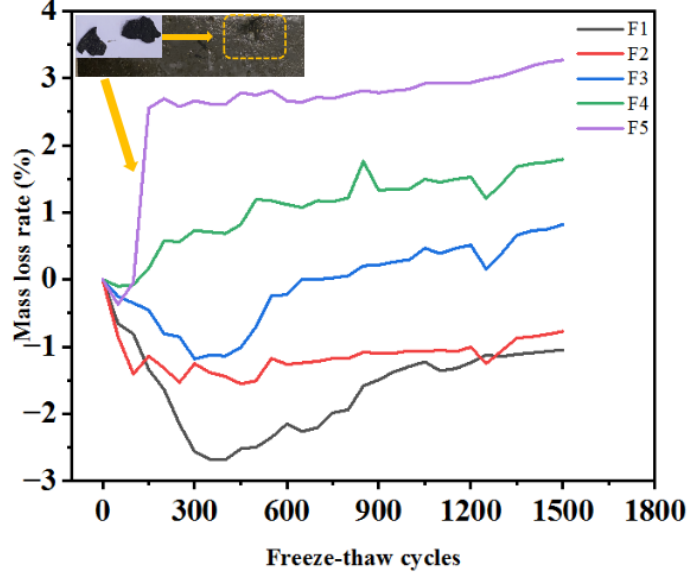
Figure 6. The mass loss rate of MWCNTs UHPC during salt freezing cycles. (F1: Composite salt and FT coupling; F2: Bicarbonate and FT coupling F3: Chloride salt and FT coupling; F4: Sulphate and FT coupling; F5: Clean water and FT coupling).